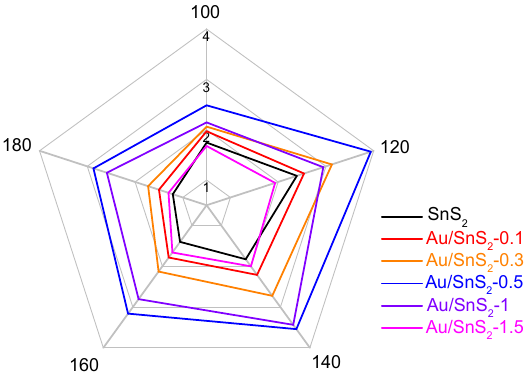
Figure 7. The response of as-fabricated sensors to 4 ppm NO 2 in the temperature range of 100 °C to 180 °C.